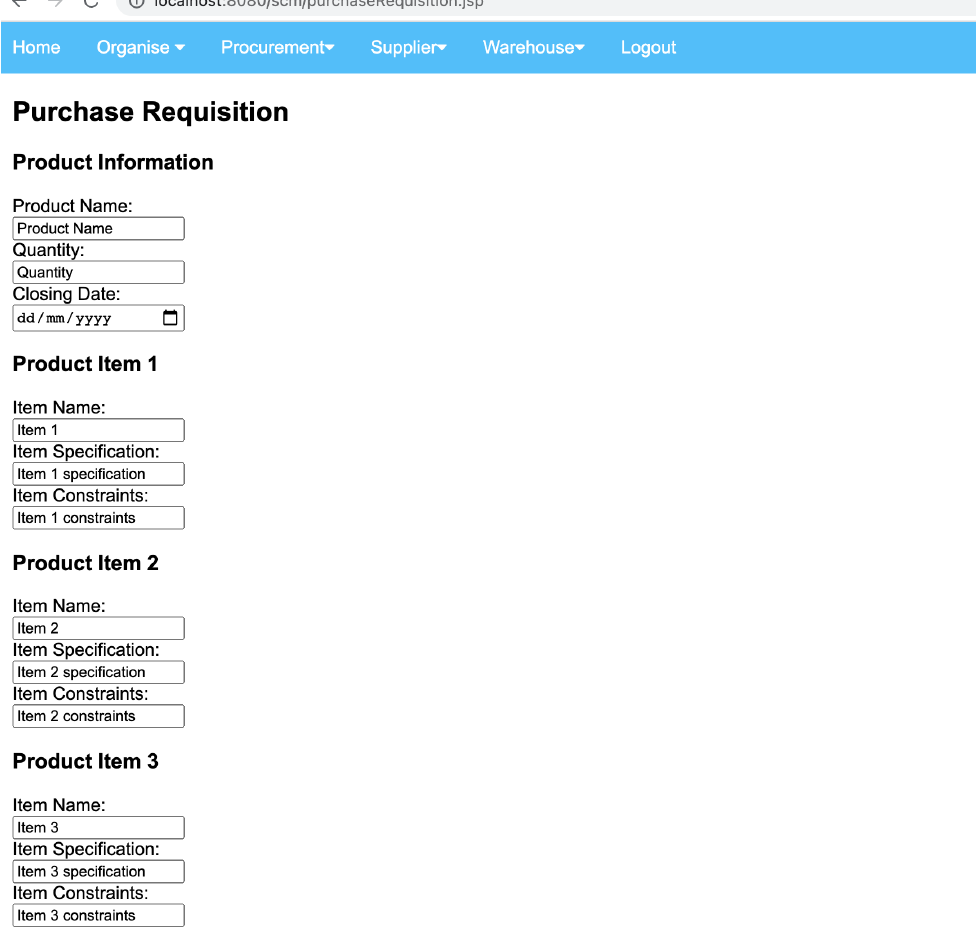
Figure 3. Supply chain ICT